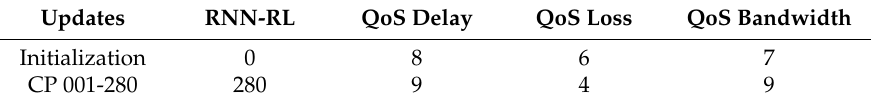
Table 12. Deep Learning Cluster vs. RNN-RL (4 × 4